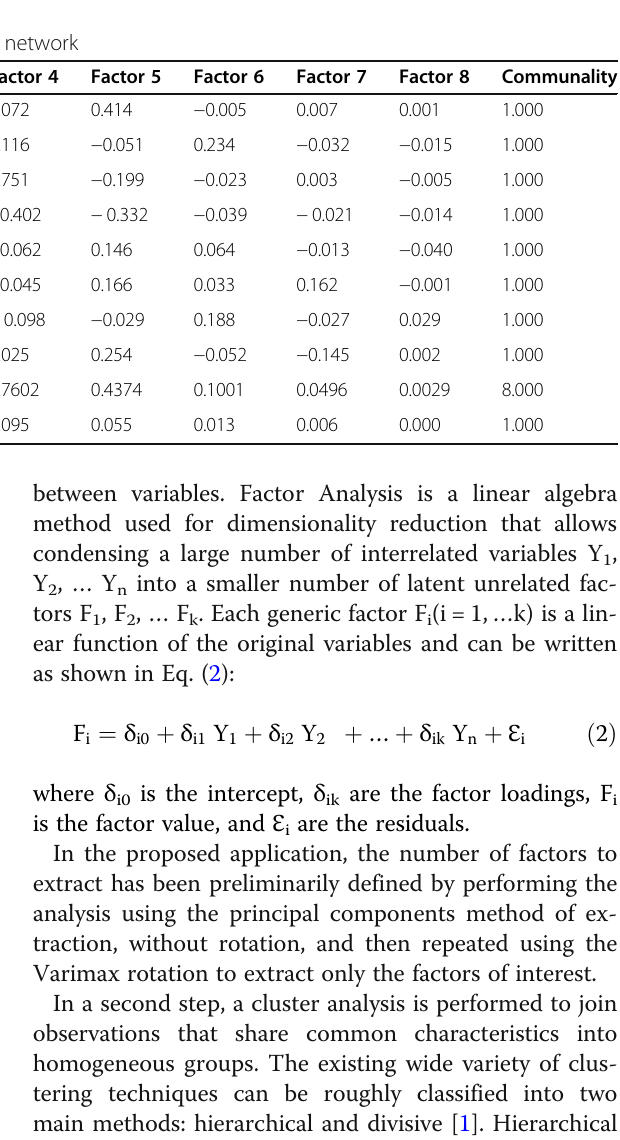
NS - N. of intermediate Stops